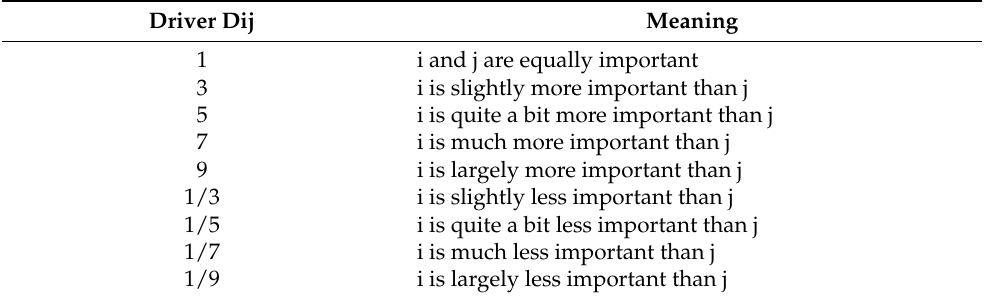
Table 2. Analytical Hierarchical Process (AHP) method: scale of relative importance.